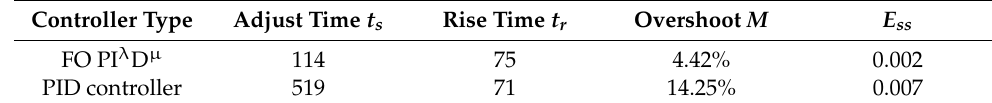
Table 3. Performance of PID and FO PI λ D µ controller.